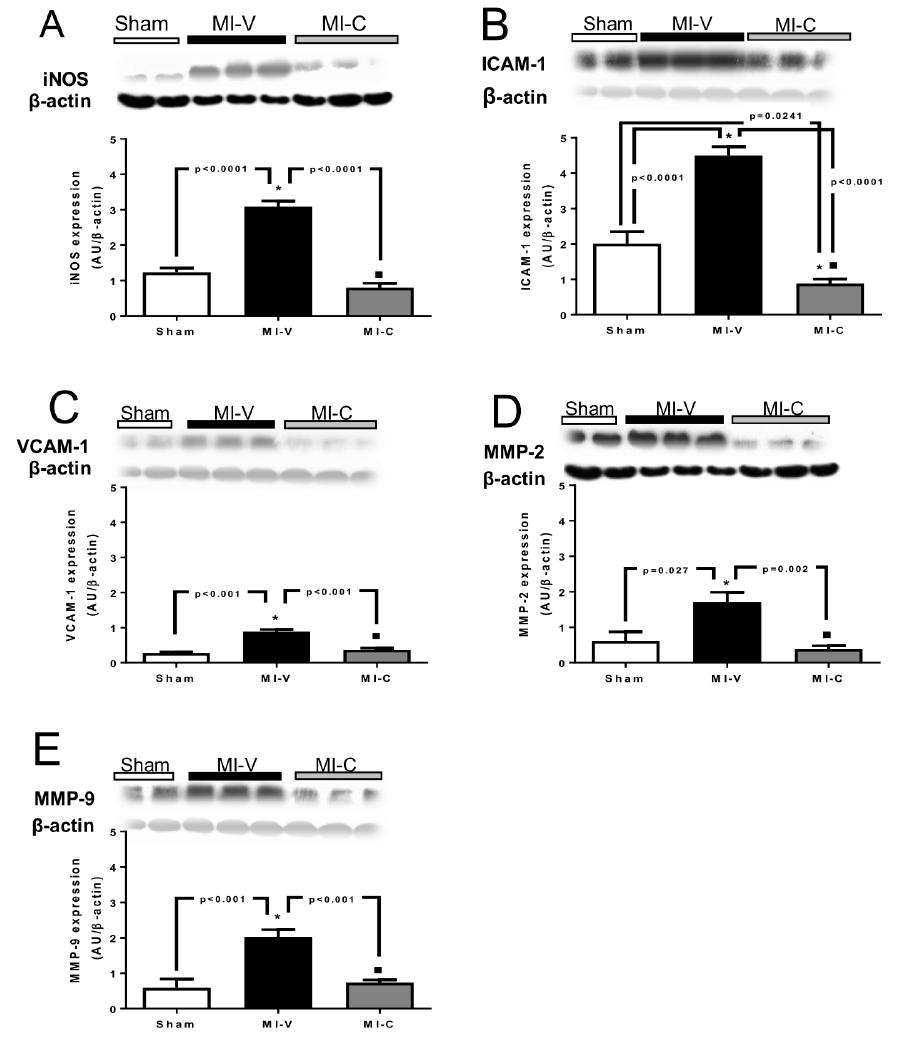
Figure 2. Protein expression of ( A ) iNOS, ( B ) ICAM-1, ( C ) VCAM-1, ( D ) MMP-2, and ( E ) MMP-9 in Sham, myocardial infarction-vehicle (MI-V), and MI clofibrate-treated (MI-C) rats. Each panel shows a representative Western blot and densitometric analysis. β -actin was used as load control and for densitometric normalizing. Image corresponding to β -actin were re-used for illustrative purposes. Bars represent the mean ± standard error; n = 6 rats per group, ANOVA-Tukey * p < 0.05 vs. Sham and ■ p < 0.05 vs. MI-V.